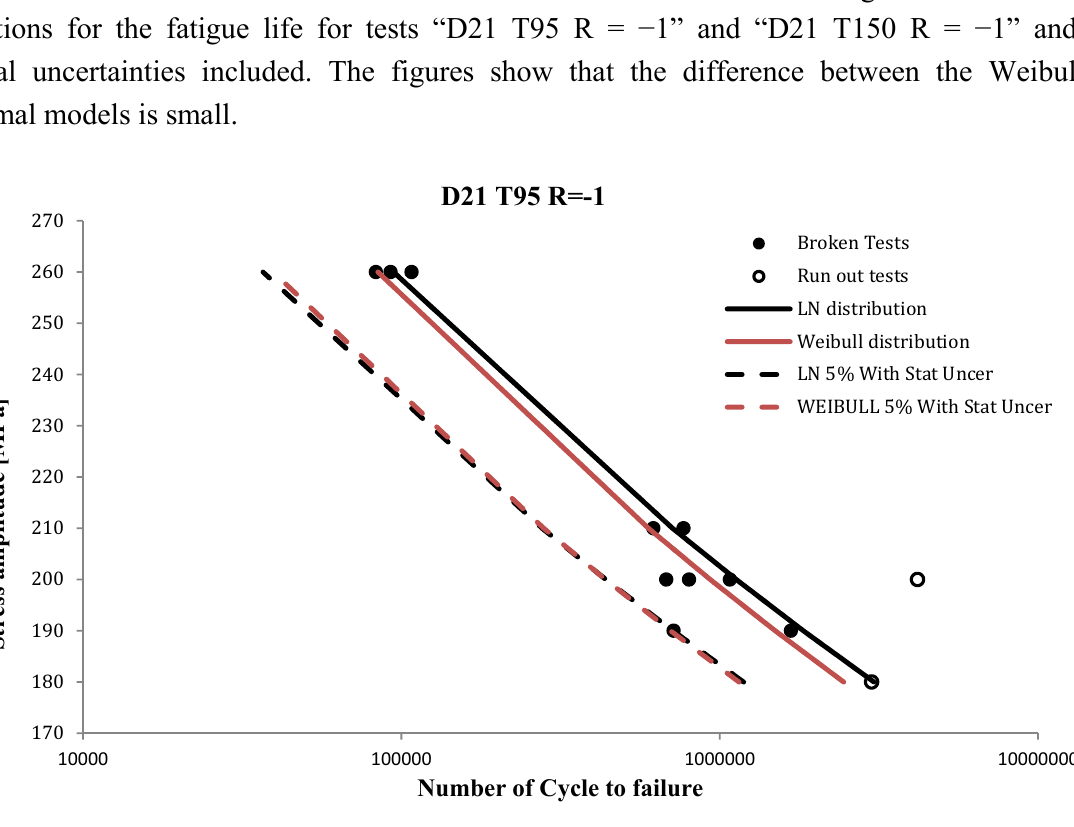
Figure 2. SN data for test D21 T95 R = − 1 with fitted mean and characteristic SN